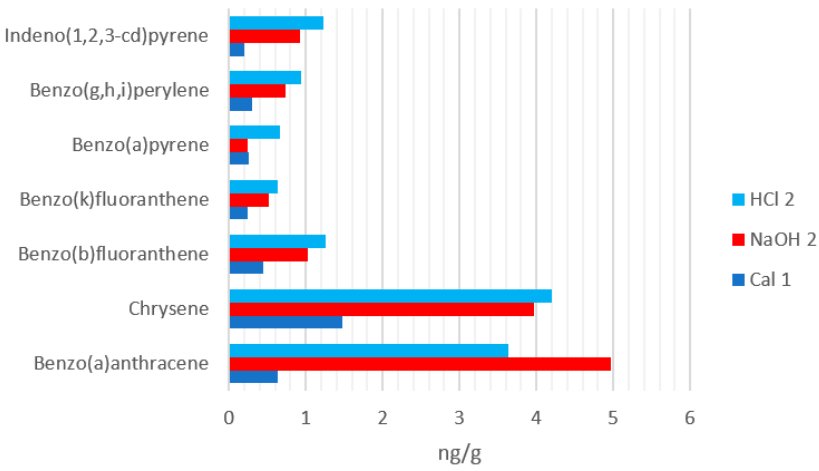
Figure 10. Polycyclic aromatic hydrocarbons (PAHs) adsorption on the different zeolites.